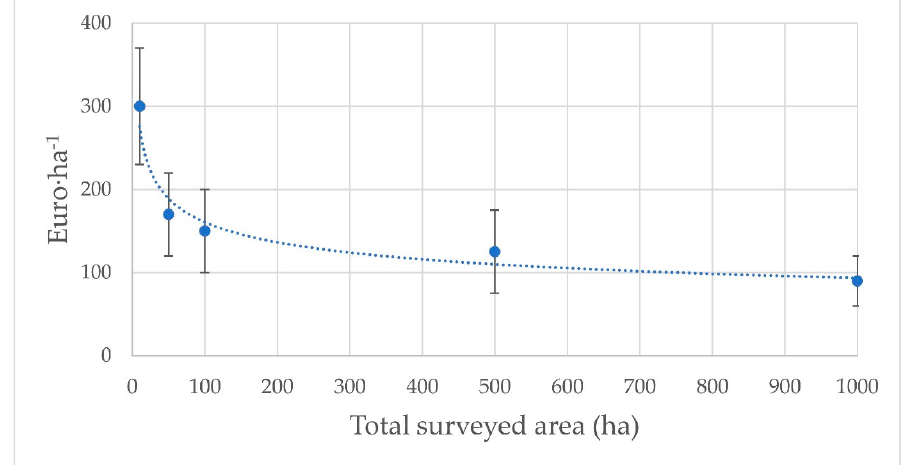
Figure 5. Cost estimation per hectare of high detail soil survey, carried out by proximal sensing, direct observations of calibration points by manual augerings, laboratory standard analysis of the surficial and sub-surficial soil horizons.